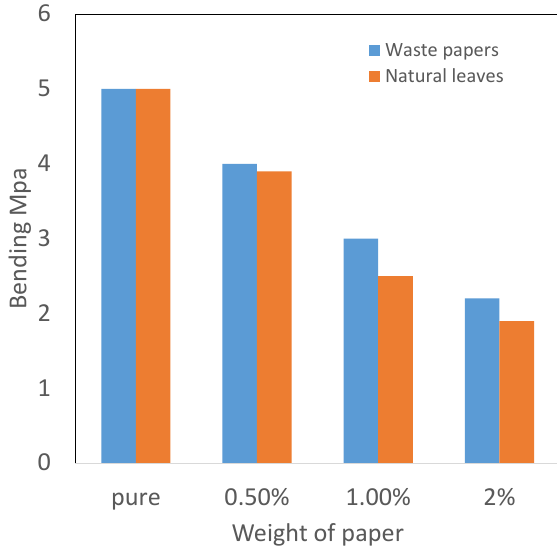
Fig. 13: Bending test of the